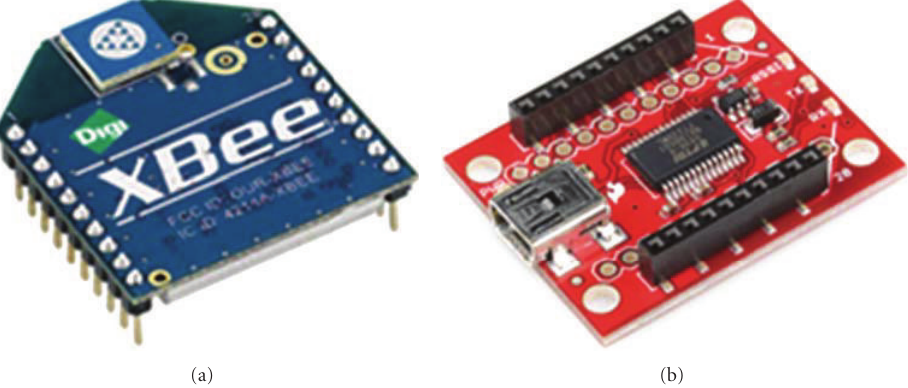
Figure 15: (a) XBee Pro module. (b) XBee Explorer USB.